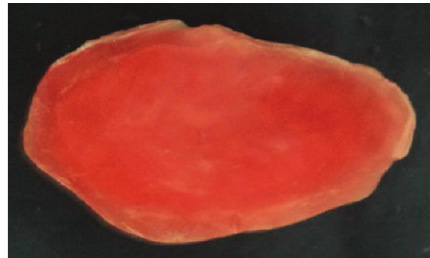
Figure 5: Waxed-up bulb.